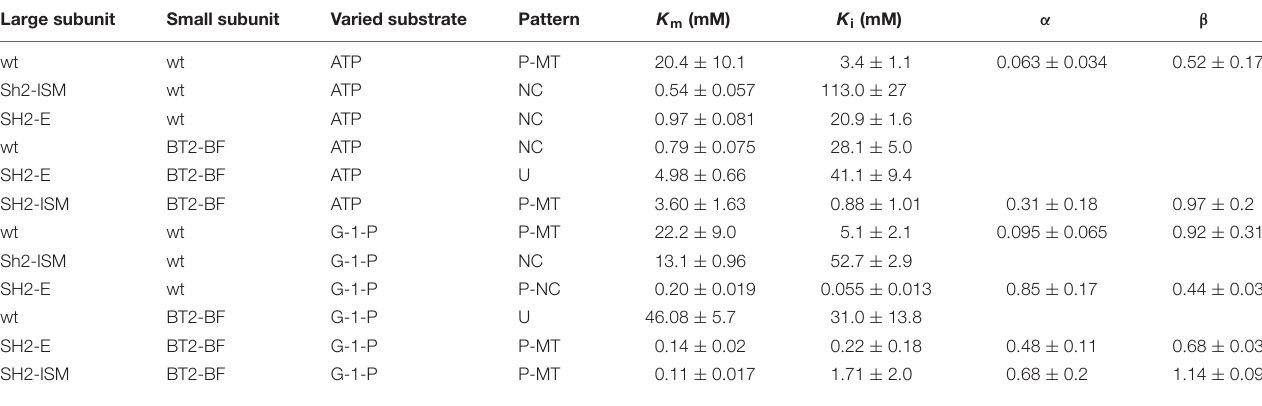
TABLE 6 | Pi inhibition in the absence of 3-PGA of various AGPases. Large subunit Small subunit Varied